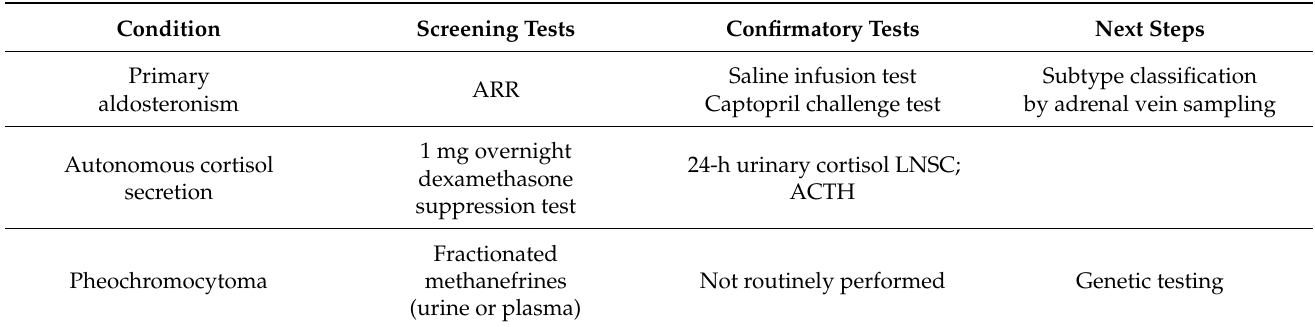
Table 1. Laboratory tests to identify functionally active adrenal